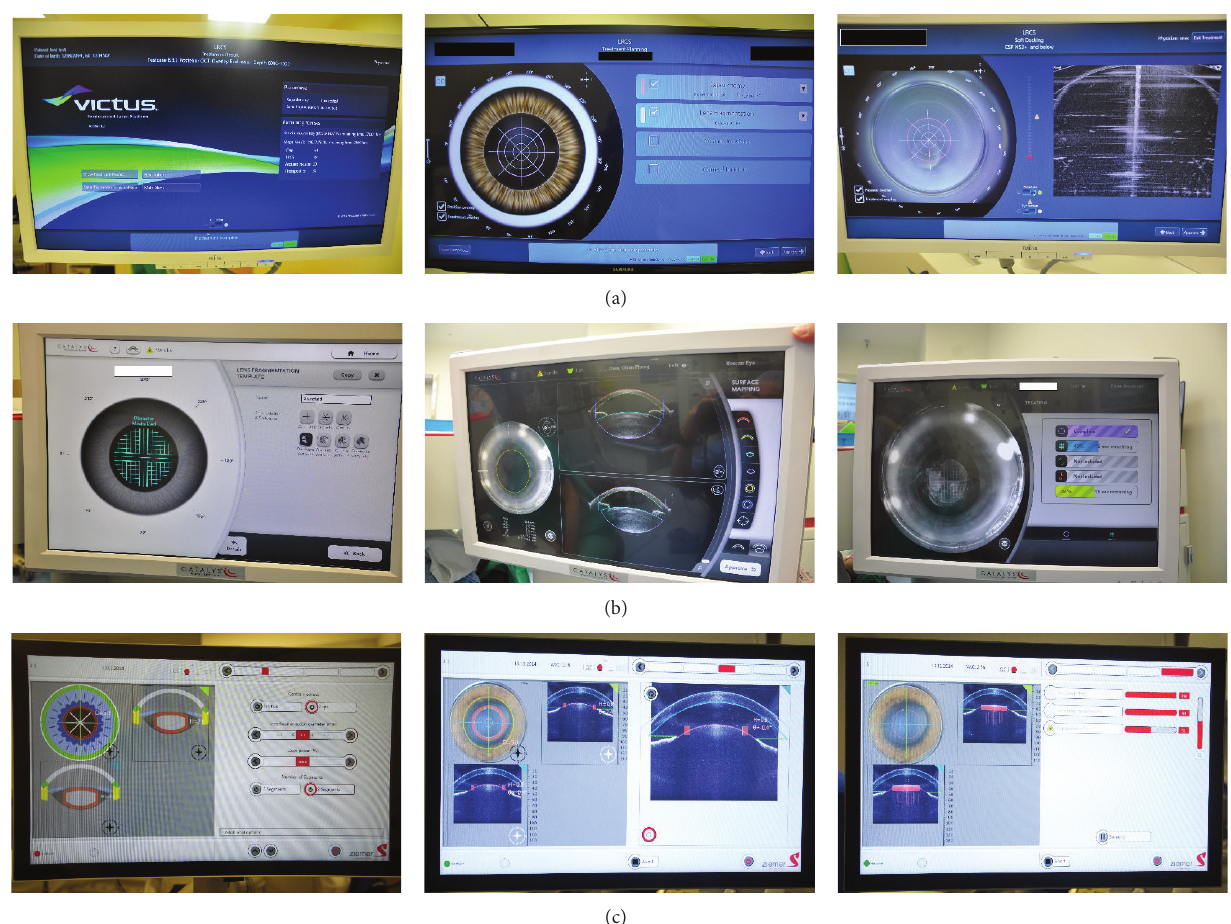
Figure 4: Screen shots of three femtosecond laser platforms’ user interfaces. (a) Victus: (left) menu screen; (middle): selection options for FLACS procedure; (right) OCT imaging step. (b) Catalys: (left) pattern selection for lens fragmentation; (middle) OCT lens imaging; (right) FLACS progression bars: (purple) capsulotomy, (green) lens fragmentation, and (yellow) overall progression. (c) LDV Z8: (left) selection menu for FLACS parameters; (middle) OCT lens imaging; (right) (top red bar) vacuum suction pressure, (middle red bar) lens fragmentation progress, and (bottom red bar) capsulotomy